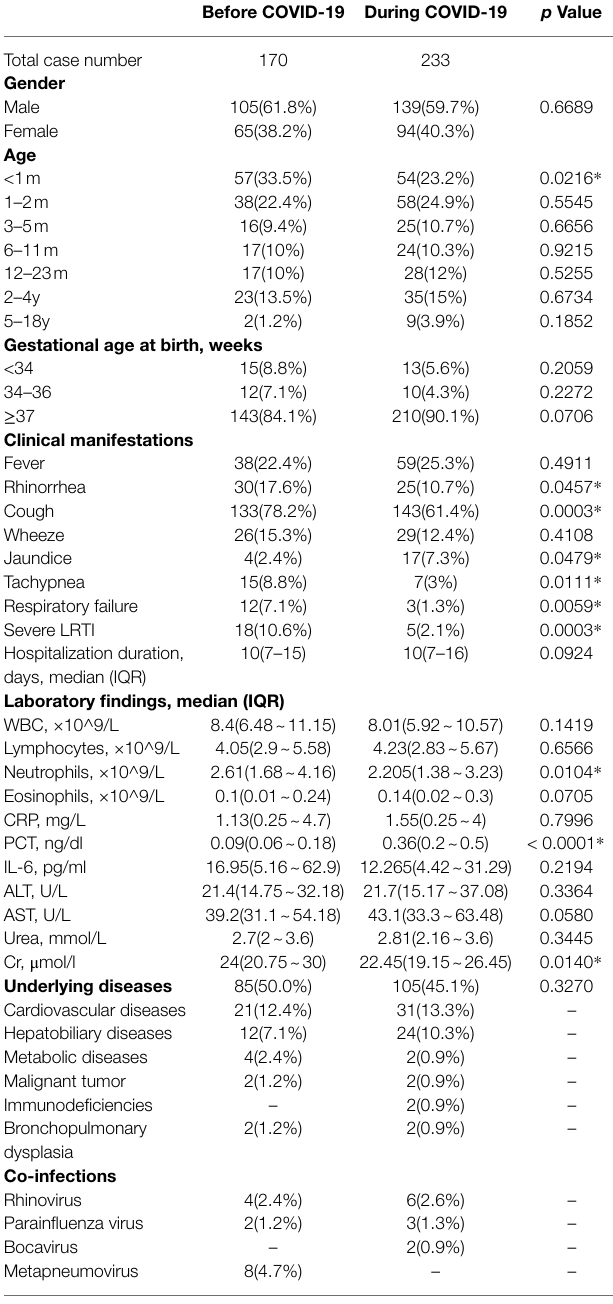
TABLE 1 | Demographic and clinical features of RSV-positive patients before and during COVID-19. Before COVID-19 During